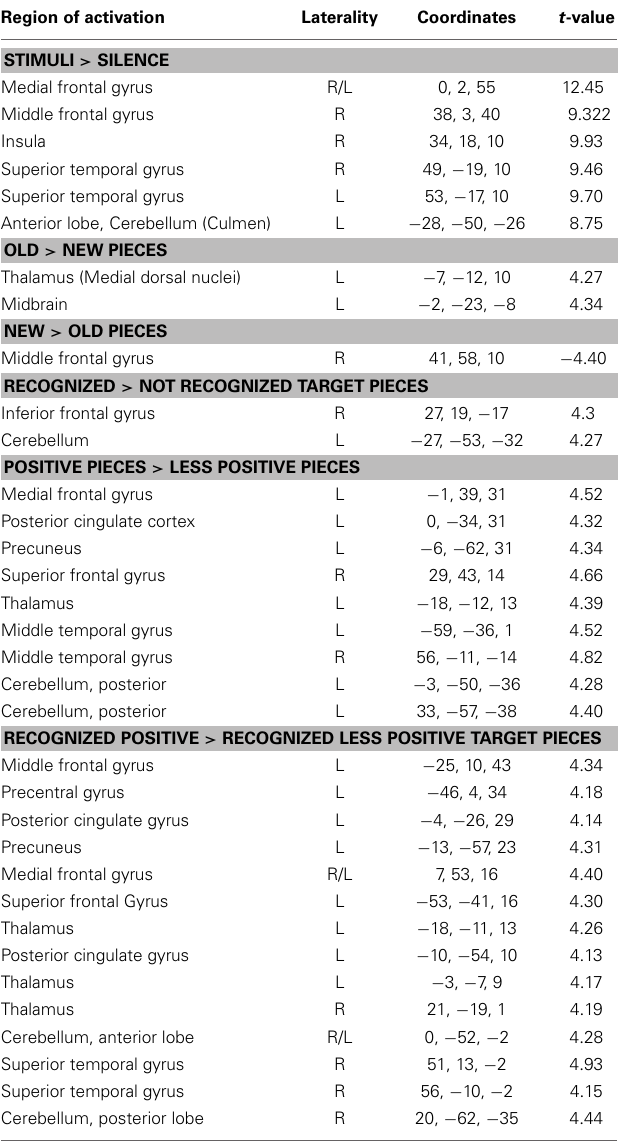
Table 1 | Laterality (R, right, L, left), coordinates and t -values for every contrast and active brain